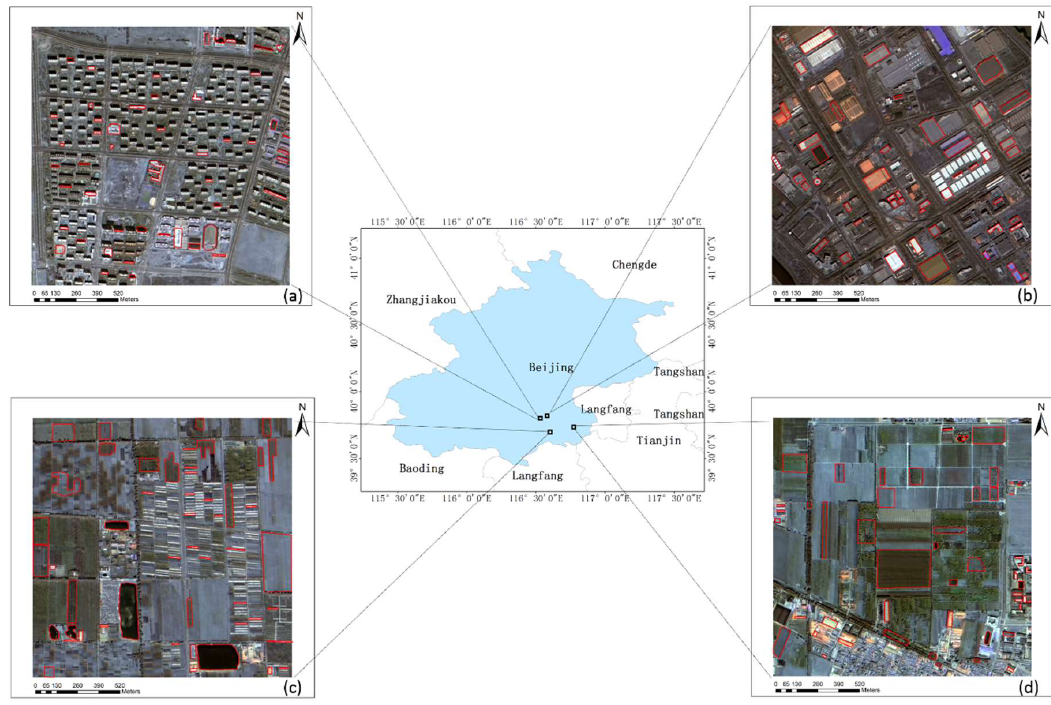
Figure 3. Four study areas of the gaofen-1 (GF-1) image: ( a ) T1, residential area, ( b ) T2, industrial area, ( c ) T3, farmland area includes vegetation, farmland, water, and a cultivation hothouse, and ( d )